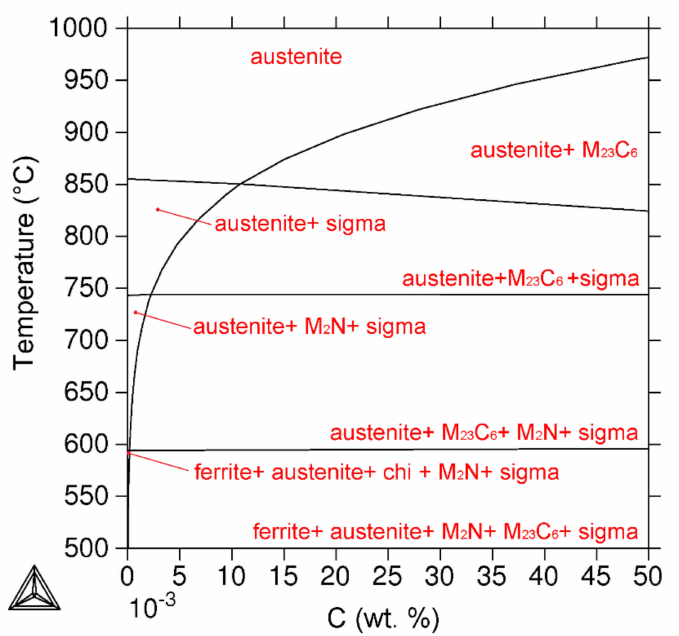
Figure 8. Equilibrium phase diagram for AISI 316L